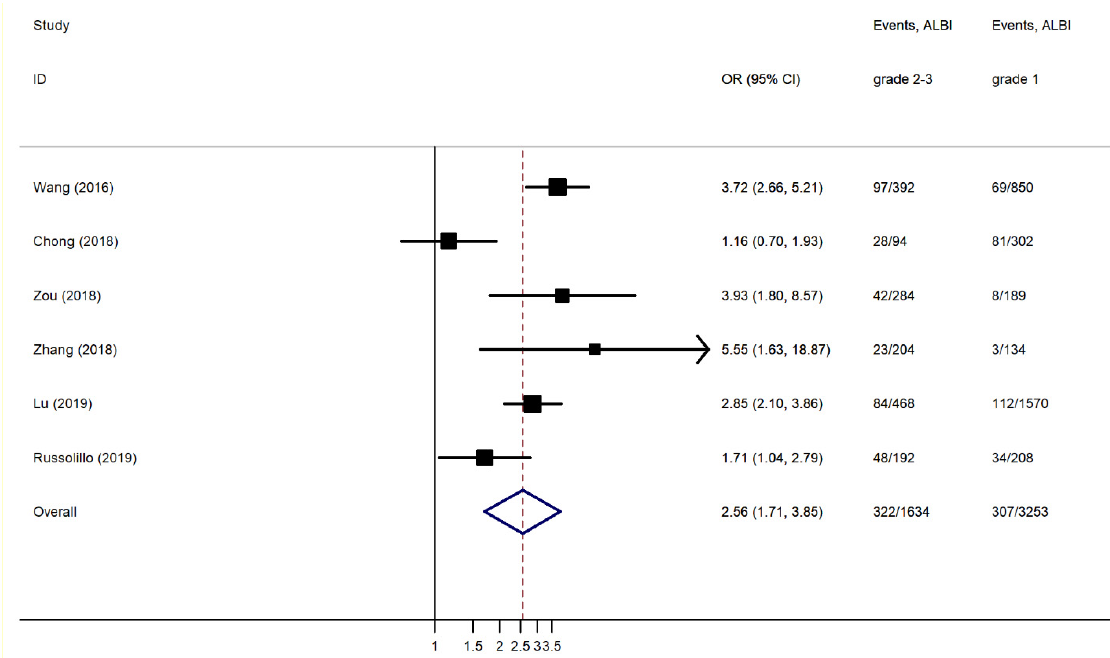
Figure 3. Funnel plot visual to asymmetry. Legend: OR: Odd Ratio. se(logOR): Standard Error of log OR. Dotted black line: the line of pseudo 95% confidence limits. Solid black line: the line of overall effect. Blue point: each study included. Orange line: Egger’s test.